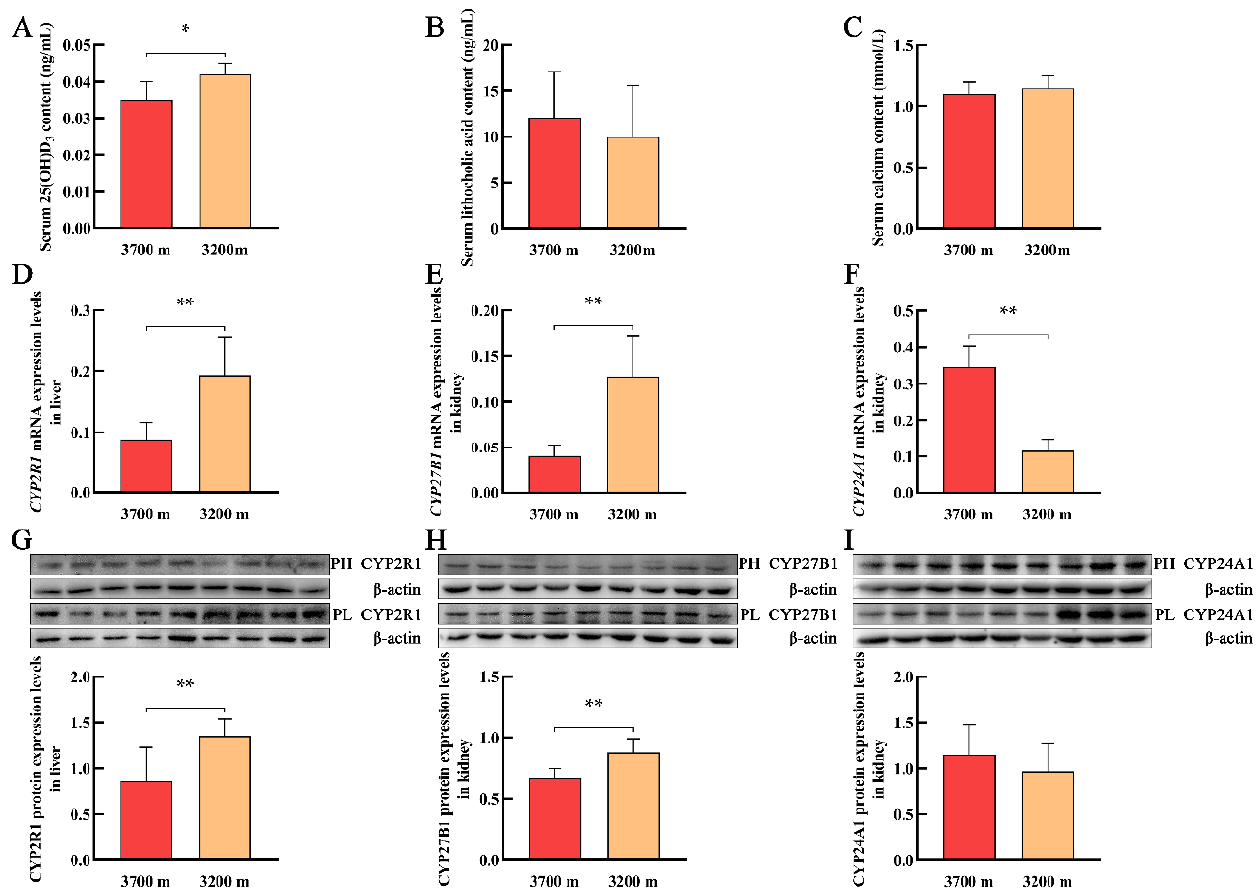
Figure 3. Serum levels of 25(OH)D 3 , lithocholic acid, and calcium and the expression levels of CYP2R1, CYP27B1, and CYP24A1 in the liver and kidney of plateau pika at different altitudes. ( A – C ) represent the serum levels of 25(OH)D 3 , lithocholic acid, and calcium, respectively. The mRNA ( D ) and protein ( G ) expression levels of CYP2R1 in the liver. The mRNA ( E ) and protein ( H ) expression levels of CYP27B1 in the kidney. The mRNA ( F ) and protein ( I ) expression levels of CYP24A1 in the kidney. PH and PL represent the plateau pika at elevations of 3700 m and 3200 m, respectively. * p < 0.05, ** p < 0.01. (original Western blot figures are in Figure S3.).